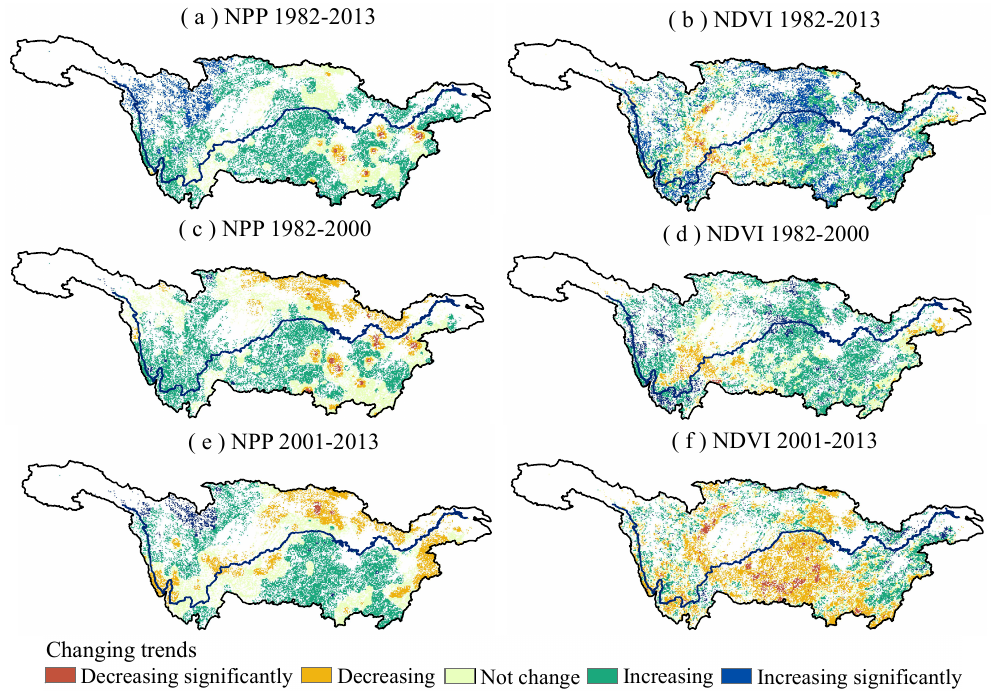
Figure 4. Changing trends of annual mean forest NPP and NDVI in the Yangtze River basin during the period 1982–2013.